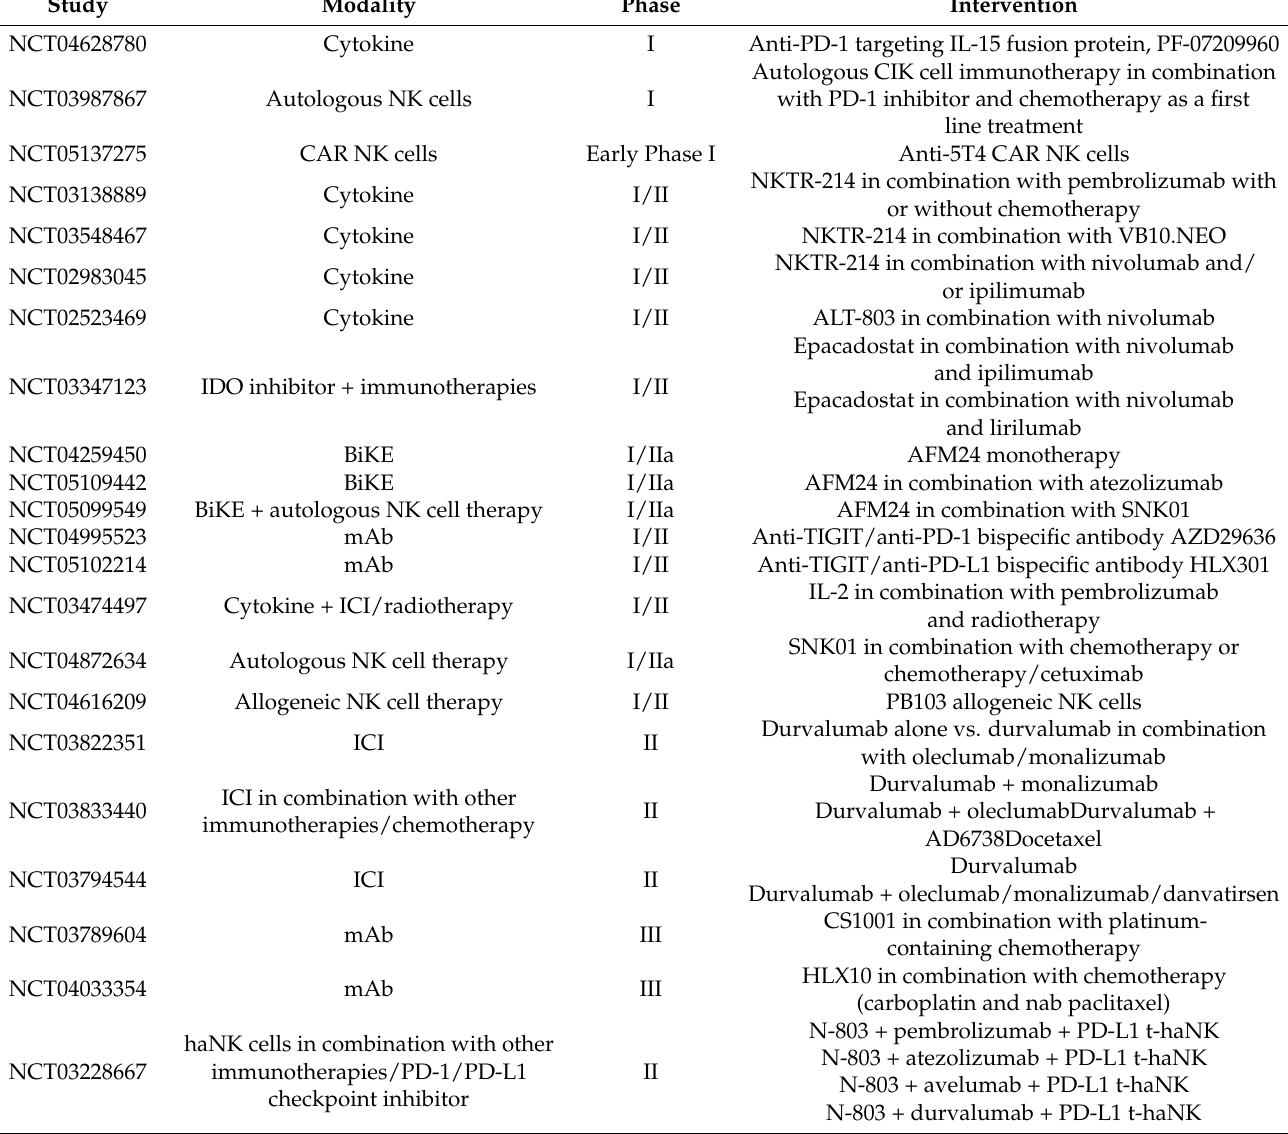
Table 2. NK cell-based immunotherapies in clinical trials for